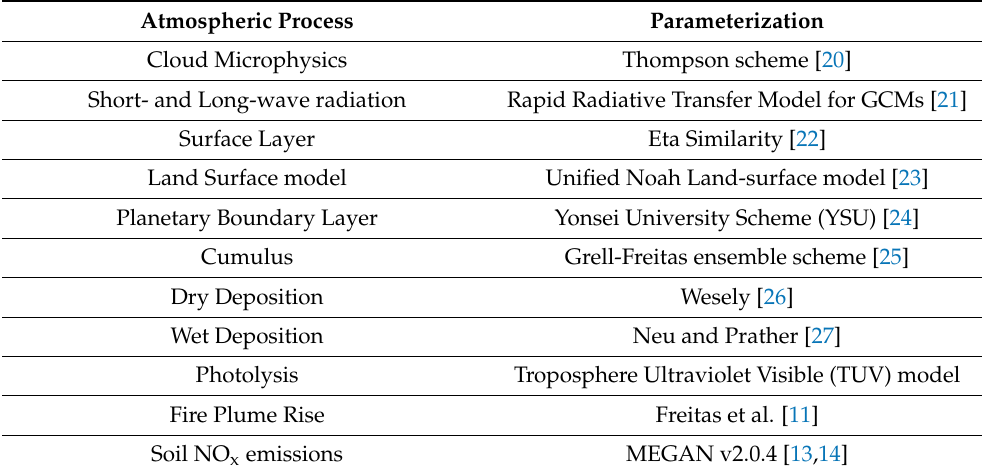
Table 1. Parameterizations used for selected atmospheric processes in the NCAR regional air quality forecasting